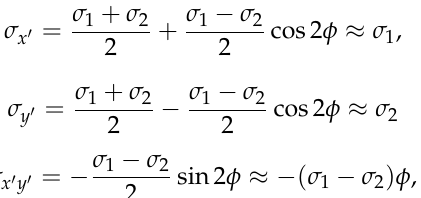
Figure 4. Illustration of principal stress lines. ( a ) Stress on a small square in the material. ( b ) Principal stress and principal stress lines. ( c ) Stress on a line deviated from principal stress lines. ( d ) Stress on a line aligned to principal stress lines. Black and white arrows represent normal and shear stress, respectively.